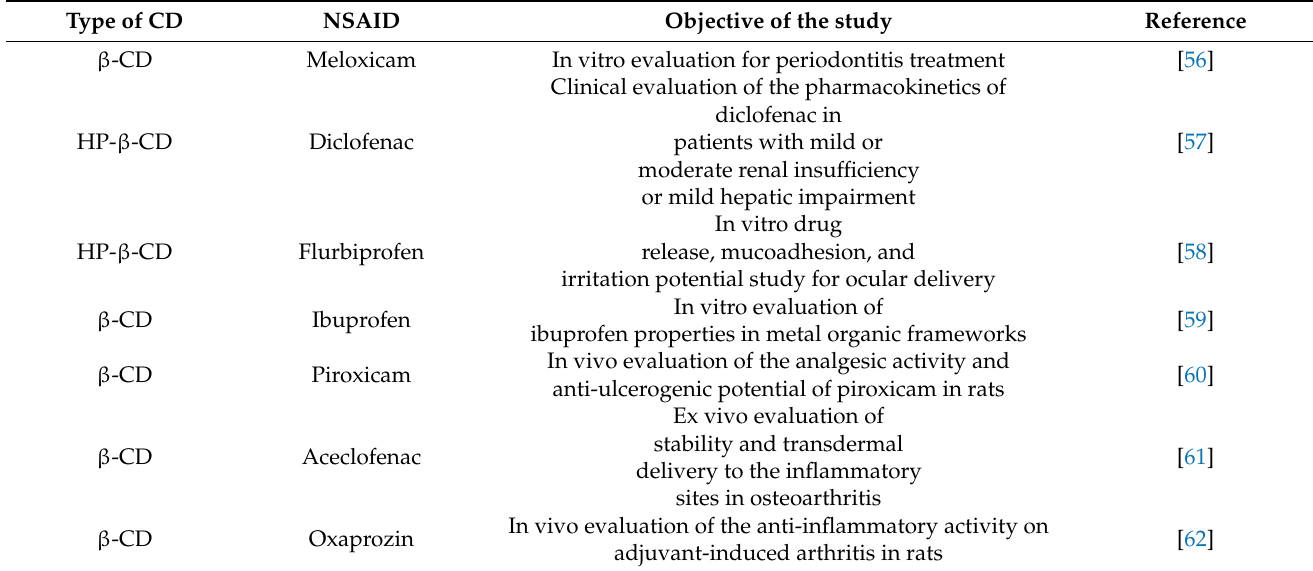
Table 1. Examples of recent studies conducted on CD-NSAID complexes.